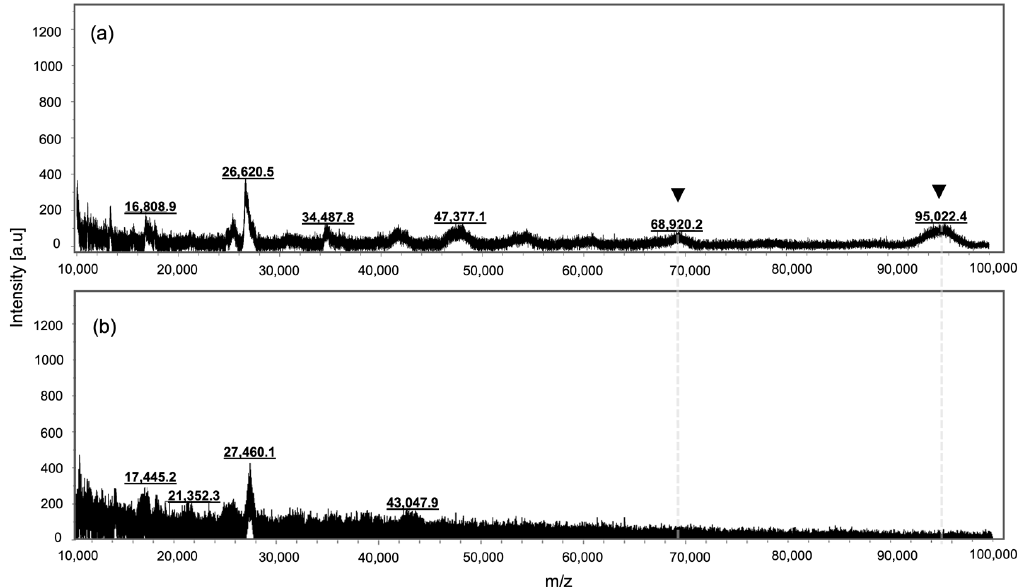
Figure 2. MALDI-TOF mass spectra for salmon gelatin ( a ) and GelMA ( b ) samples. Arrowheads indicate Mw bands from SGel absent from SGelMA samples.